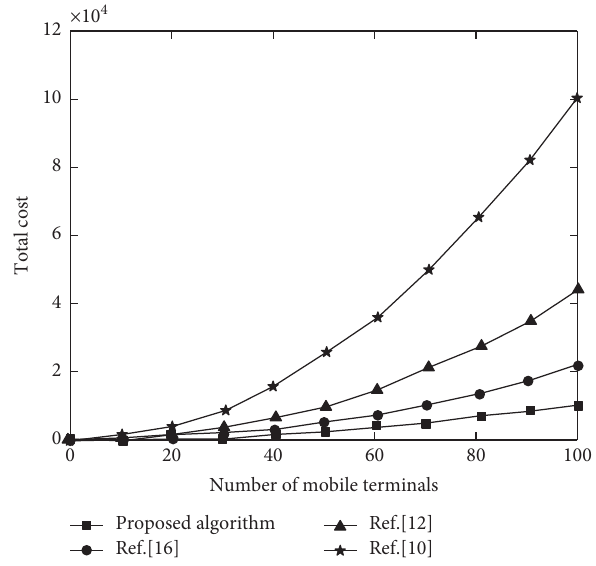
Figure 6: Effect of the number of mobile terminals on the total